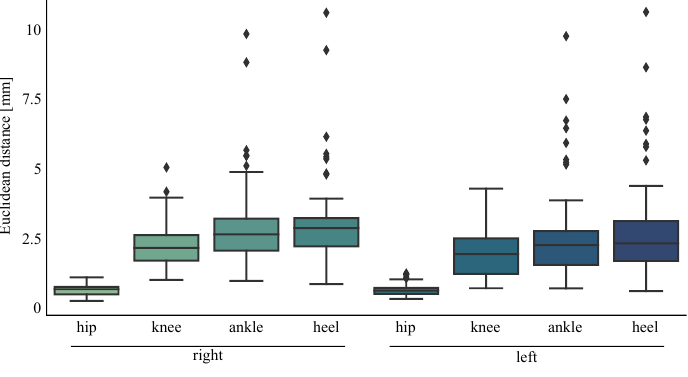
Figure 5. Euclidean distance distribution between the keypoints estimated in three synthesised versus real videos (95% confidence interval) and three real camera locations: right side anterior-sagittal, true-sagittal and posterior-sagittal to the participant’s forward direction plane of motion (TruPS1, TruTS1, TruAS1, SynPS1, SynTS1, SynAS1).